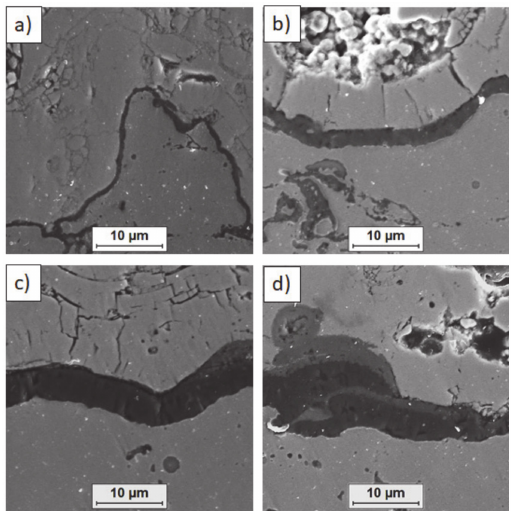
Figure 16. Ceramic layer / bond-coat interfaces of the TBC systems after 500 h of oxidation at a temperature of 1100 ◦ C—DCL La 2 Zr 2 O 7 / 50% La 2 Zr 2 O 7 + 50% 8YSZ / 8YSZ TBC (SEM): ( a , b ) zone of the bond-coat top and ( c , d ) zone of the bond-coat bottom.